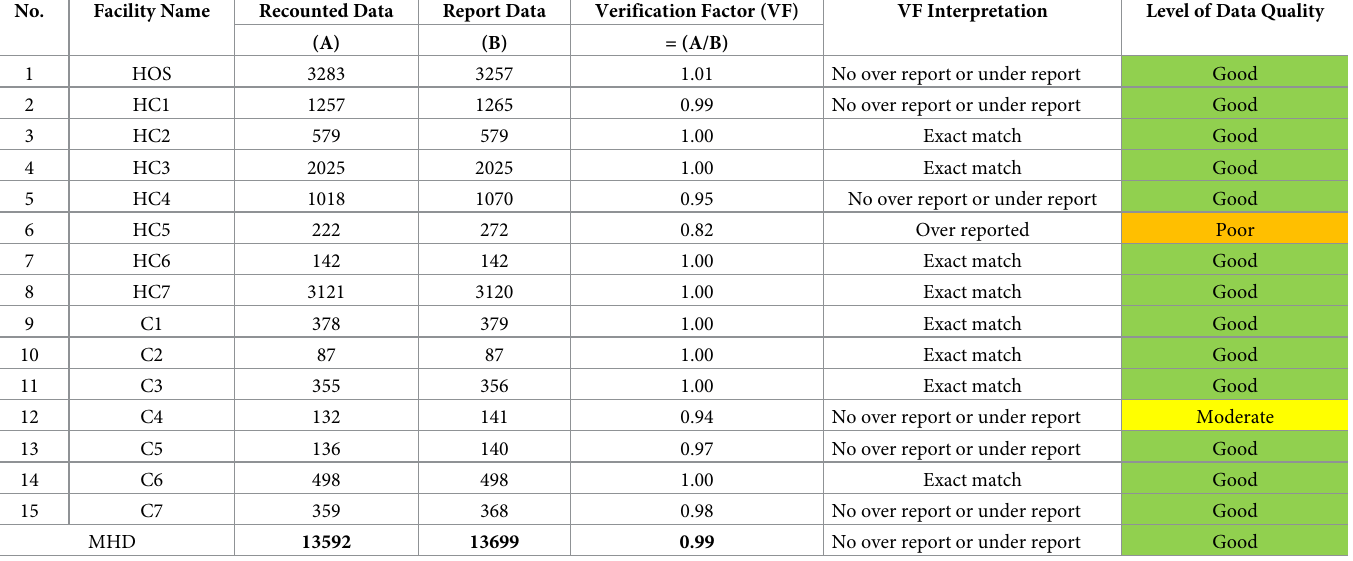
Table 6. Accuracy of reported number of malaria cases tested positive: Verification factor.